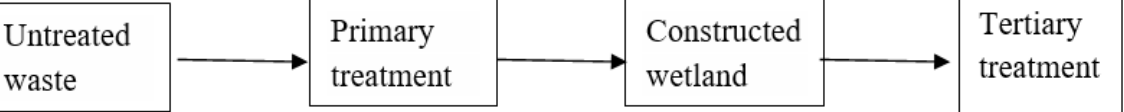
Figure 2. Surface flow ‐ constructed wetland. Horizontal Subsurface Flow ‐ Constructed Wetland (HSSF ‐ CW): This consists of an impermeable basin with a bed of gravels or rocks. Wastewater enters through the porous substrate under the bed surface, follows a horizontal path, and reaches the outlet (Figure 3). The aerobic zone is limited to the rhizosphere region, and the filtration beds remain anoxic. Organic matter is decomposed by microbial degradation in anaerobic conditions [18].